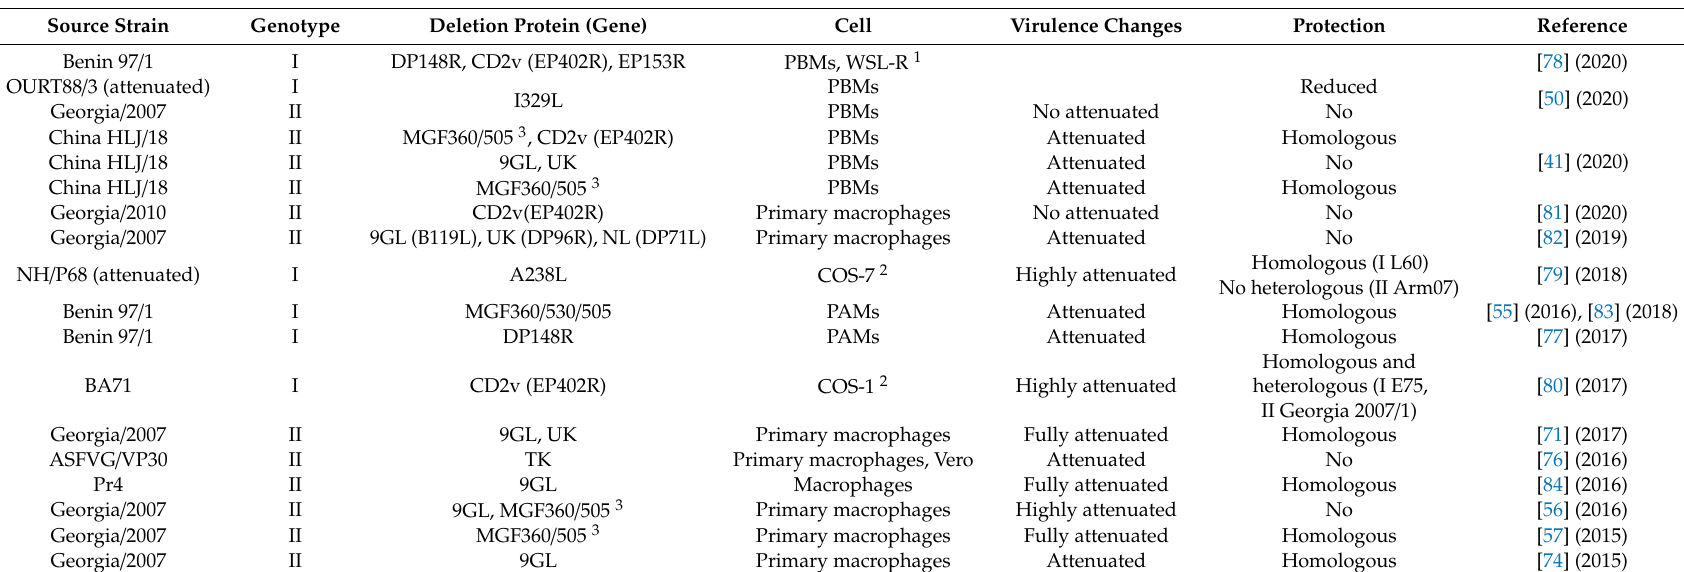
Table 3. Overview of ASF gene-deleted vaccine research